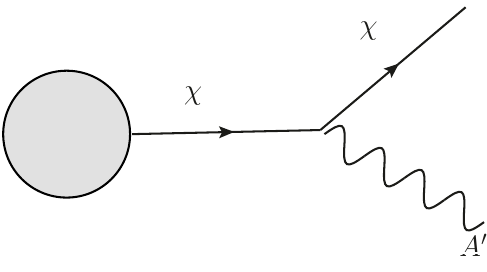
Figure 8 . The (cid:31)